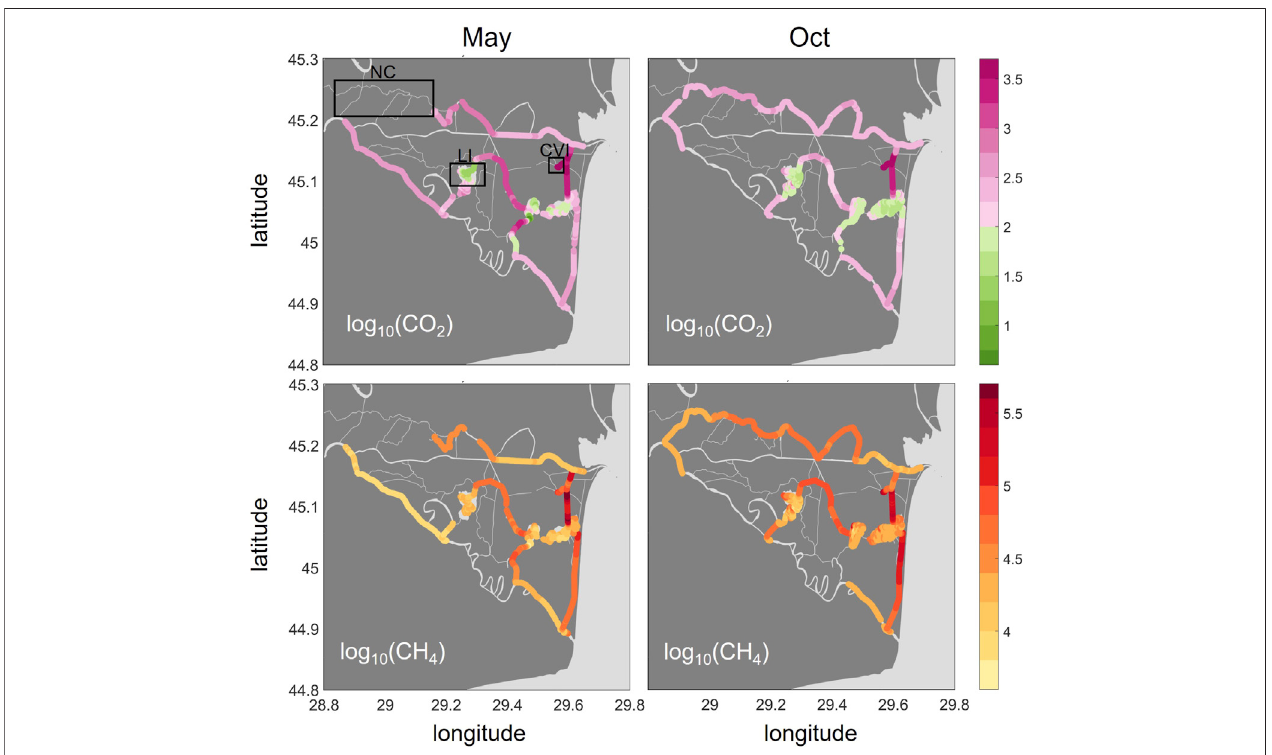
FIGURE 3 | Spatial distribution of greenhouse gas saturations (%) as CO 2 (top row) and CH 4 (bottom row) in May and October 2017 presented as log 10 (). Color coding: pink for CO 2 represents oversaturation ( > 2), green indicates undersaturation. CH 4 is oversaturated throughout the delta. The boxes in the upper left graph indicate the locations of the Northern Channels (NC), Lake Isac (LI) and Canal Vatafu-Imputita (CVI). The two plots for CH 4 were adapted from Canning A et al.